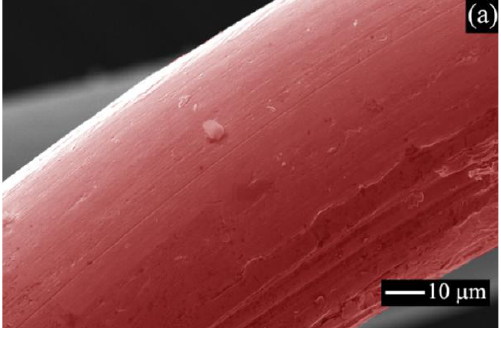
Figure 2. SEM images of the wire surface obtained at E 0 = 25 keV in SE mode for the fresh Pt – Pd – Rh – Ru gauze ( a ) and for the back ( b ) and frontal ( c ) sides of such gauze after NH 3 oxidation with air in a laboratory reactor at T ~1133 K and P ~3.6 bar for 50 h. In our studies [18 – 21], SEM and X-ray diffraction (XRD) were used to investigate the morphology and microstructure of the Pt – Pd – Rh – Ru gauze with the same composition as in this study after treatment at T = 1133 K for 50 h in air or ammonia, and also after the oxidation of NH 3 with air. It was shown that the treatment medium produced a consider- able effect on the morphology and microstructure of the gauze surface. The new gauze had mostly a smooth surface (Figure 2a) and its specific surface area was equal to 26.0 cm 2 ·g − 1 . After treatment of the gauzes in NH 3 and in air, grains with smooth and micro- faceted surface were detected [18], while after NH 3 oxidation, deep etching of the gauze surface was observed [19 – 21]. After the oxidation of NH 3 , on the back side of the first gauze along the gas flow we observed a non-uniform etched layer with the specific surface area of 52 cm 2 ·g − 1 , which includes regions 100 – 200 µm in size with a smooth surface and with ca. 3 µm crystals [19]. In Figure 2b, such a region is represented by the smooth regions marked in red (left part of the image) and by the regions with protrusions and crystals (central and right parts of the image), respectively. On the frontal side of the spent gauze, there was a continuous etched layer of porous “cauliflowers” with a size of ca. 10 µm and